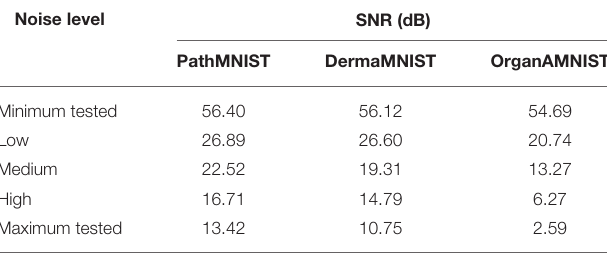
TABLE 2 | Gaussian noise levels and corresponding SNR values used in our